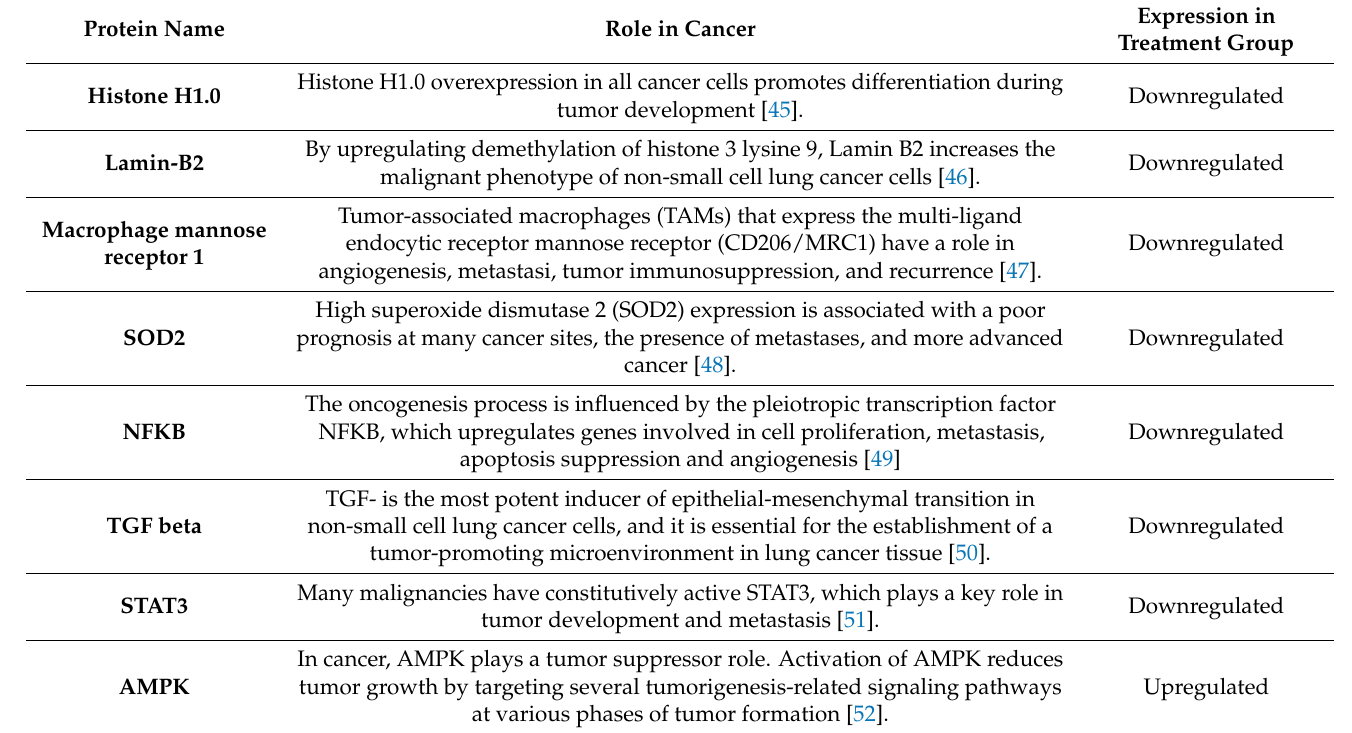
Table 3. Proteins with high abundance values and role in